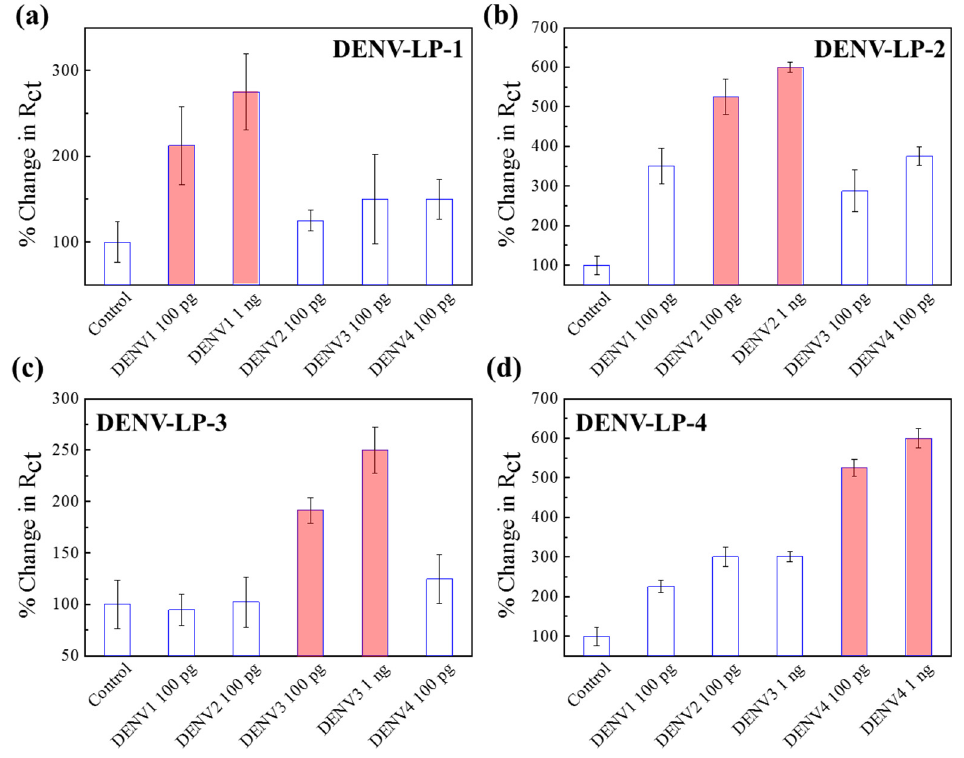
Figure 5. ( a – d ) Selectivity of four different DENV sensor electrodes with their corresponding target concentrations of 100 pg mL –1 and 1 ng mL –1 in the presence of other serotypes. Error bars represent the standard deviations of triple measurements.